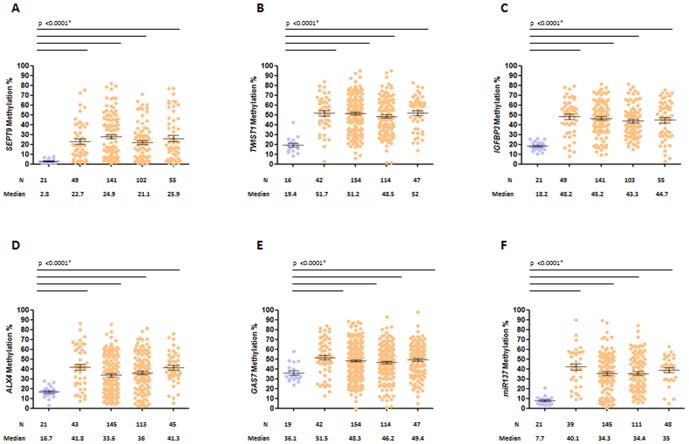
Levels of methylation in normal colonic mucosa and crc tumors from all tnm stage patients.Bisulfite pyrosequencing results of methylation of sept9 (a), twist1 (b), igfbp3 (c), alx4 (d), gas7 (e) and mir137 (f) comparing normal mucosa from healthy patients (n-n) and primary tumors from crc patients of all tnm stages i–iv. n (number of subjects); median of methylation (%).